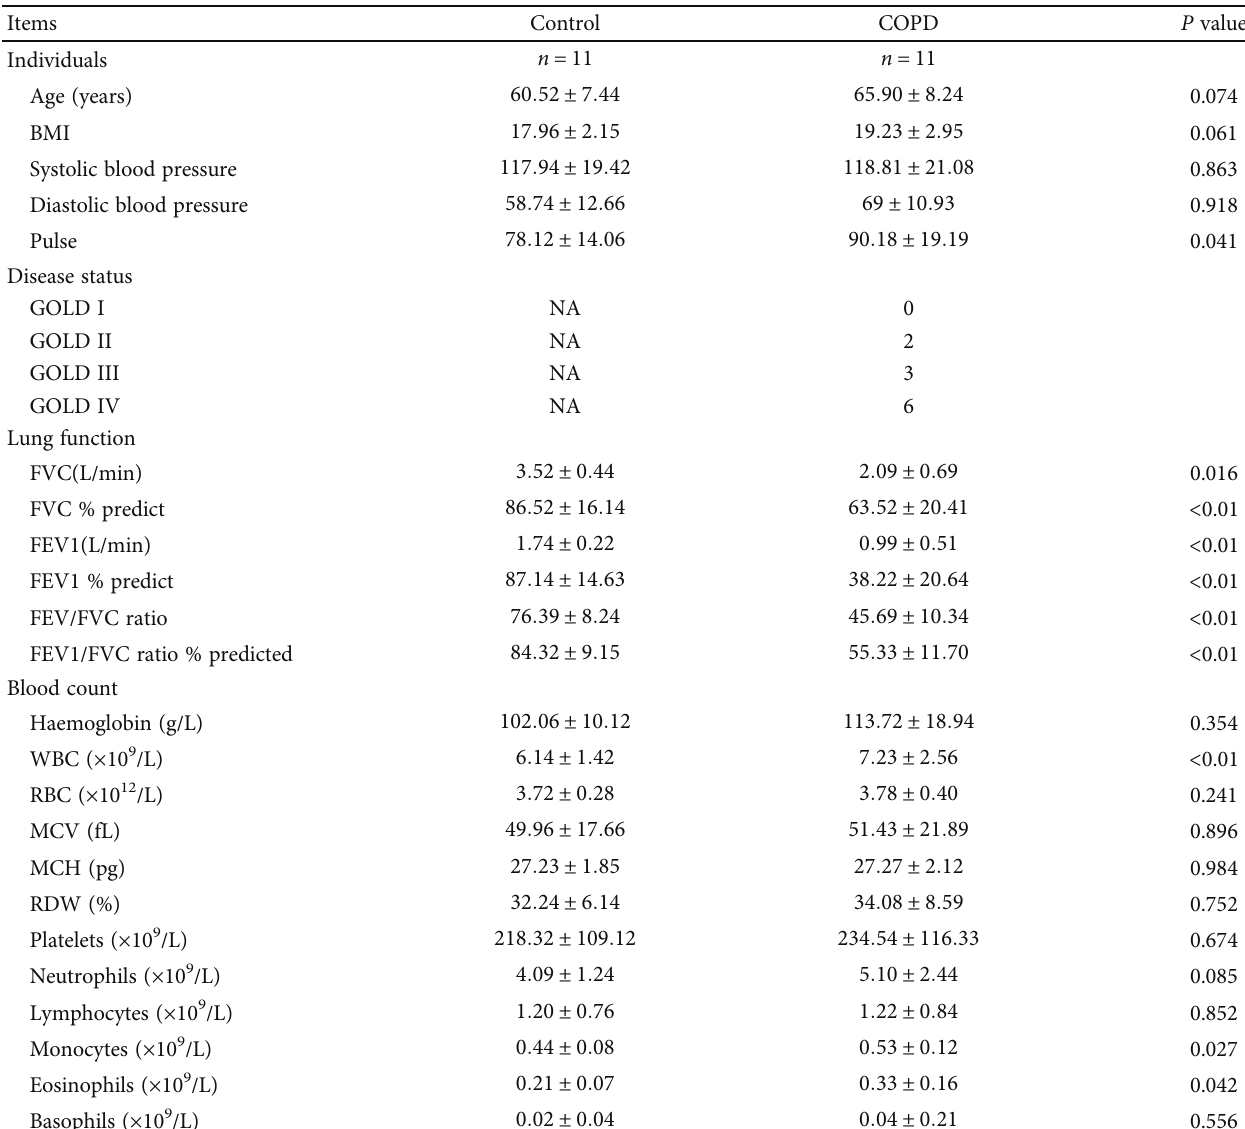
Table 1: Baseline information of